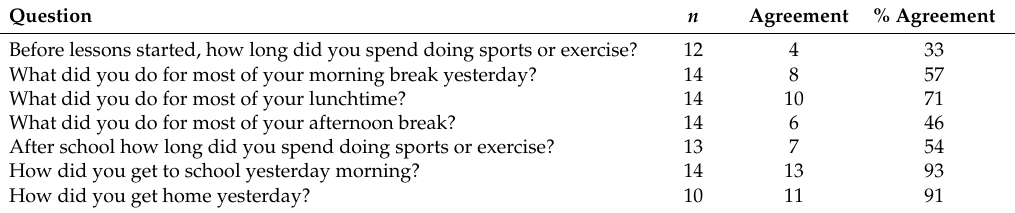
Table 3. Percentage agreement for physical activity and active transport questions when comparing self-reports to accelerometry.